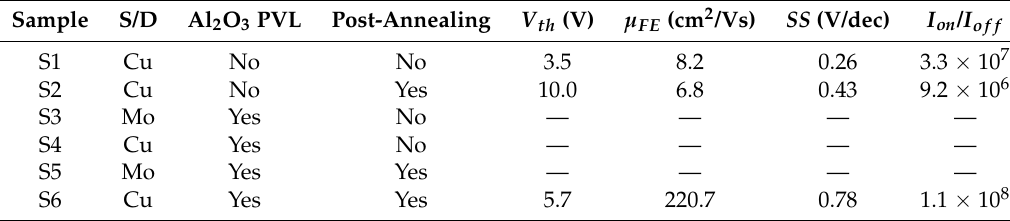
Table 1. Device performance for both a-IGZO